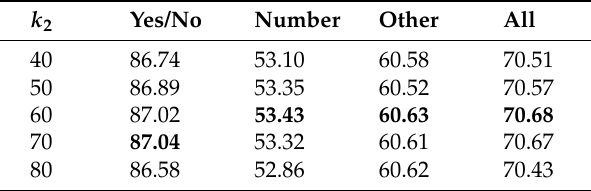
Figure 4. ( a ) The Yes/No accuracy of MCAN, MEDAN, and MESAN-SA with different k . ( b ) The Number accuracy of MCAN, MEDAN, and MESAN-SA with different k . ( c ) The Other accuracy of MCAN, MEDAN, and MESAN-SA with different k . ( d ) The Overall accuracy of MCAN, MEDAN, and MESAN-SA with different k . All the reported results are evaluated on VQA v2 test-dev set. Table 2. Ablation results of MESAN-SA&SGA on VQA v2 test-dev set. The best results are